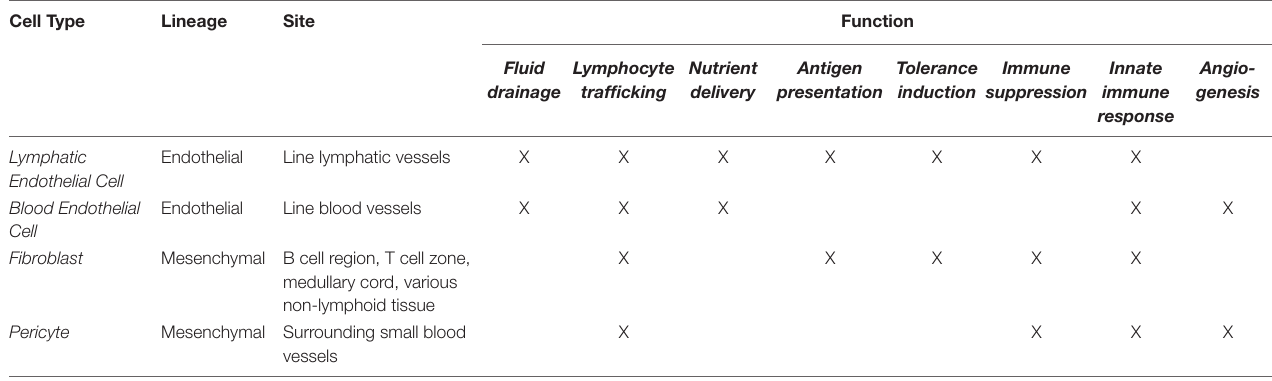
TABLE 1 | Heterogeneity in function of lymph node and non-lymphoid tissue stromal cells. Cell